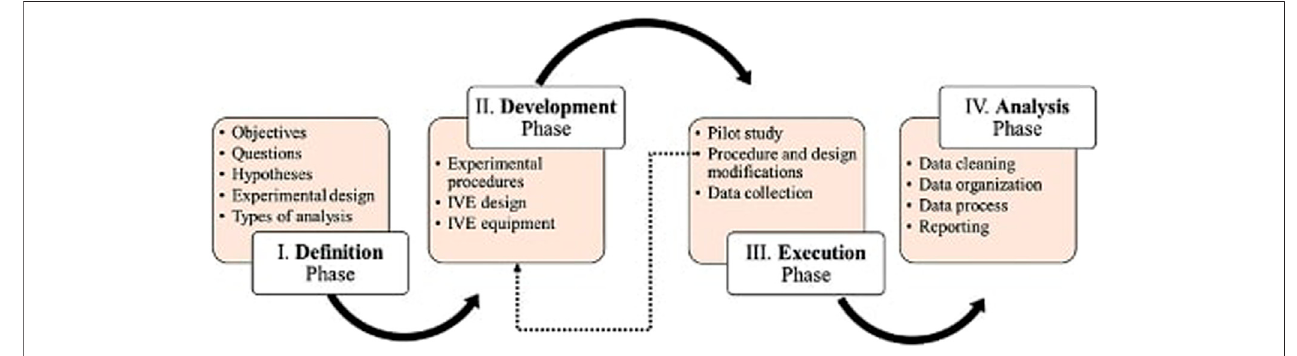
FIGURE 1 | Four phases of IVE-based experimental